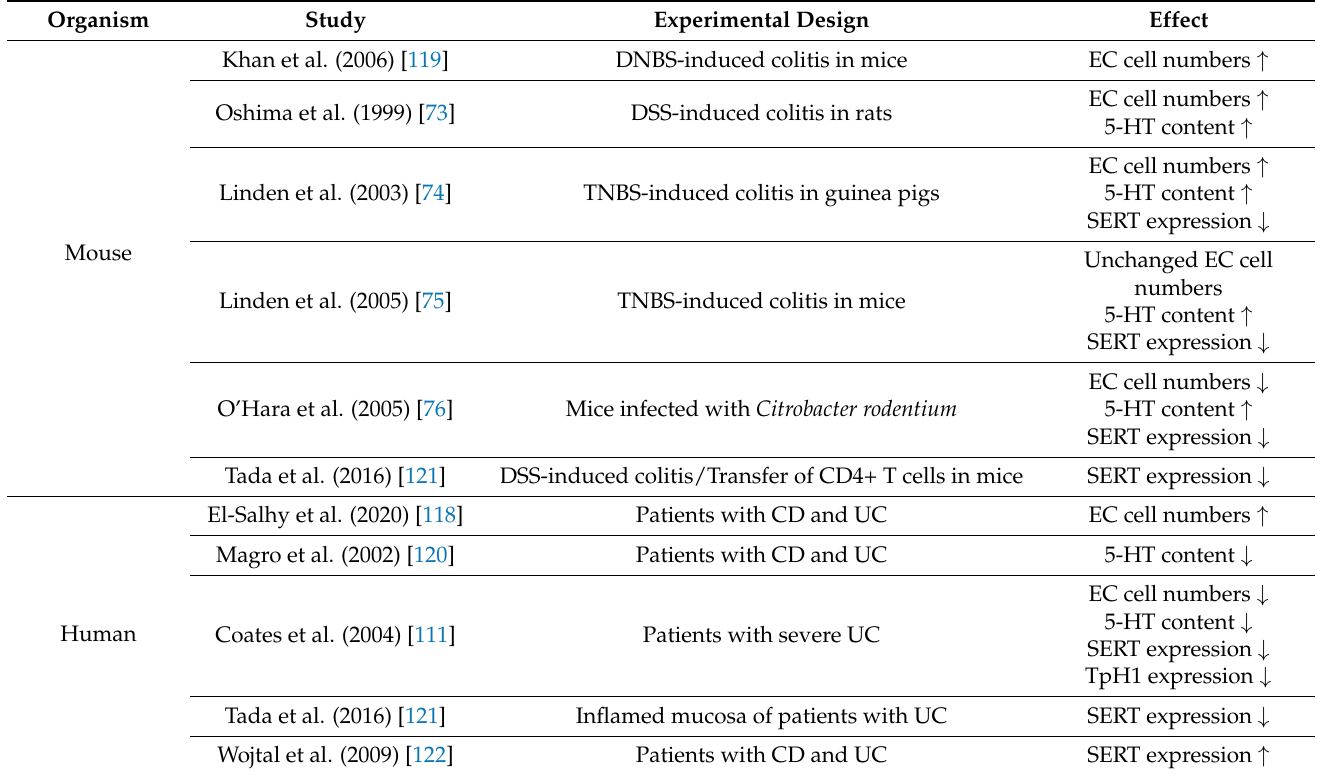
Table 5. Alterations in intestinal 5-HT signaling in animal IBD models and in patient-derived material. Organism